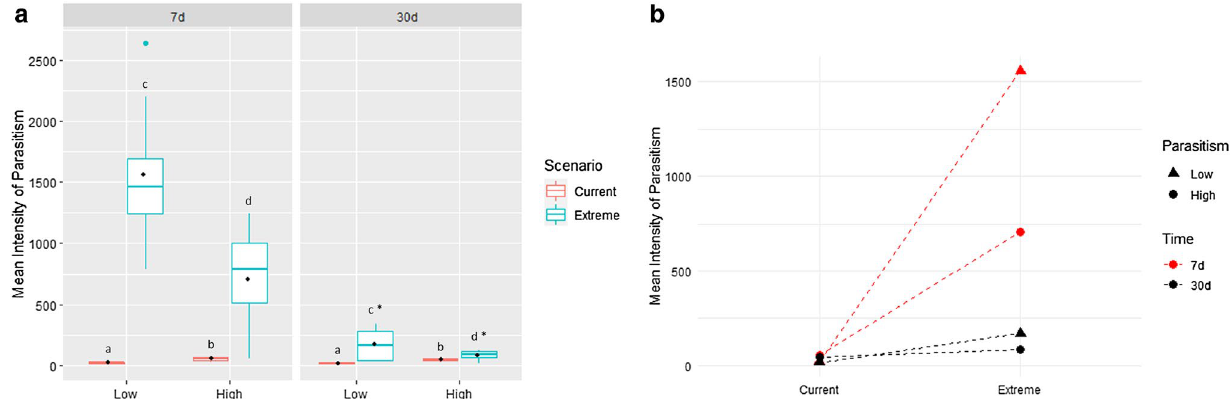
Figure 1. Mean intensity of parasitism in fish exposed to 7 and 30 days of extreme climate scenario ( a ) and a plot indicating the interaction between the parasitism levels and the period of exposure ( b ). Low (LG) and High (HG) indicate parasitism level. Boxes with different letters indicate differences between scenarios and asterisks indicate differences between exposure periods ( p < 0.05). A black dot in the box indicates the average of each